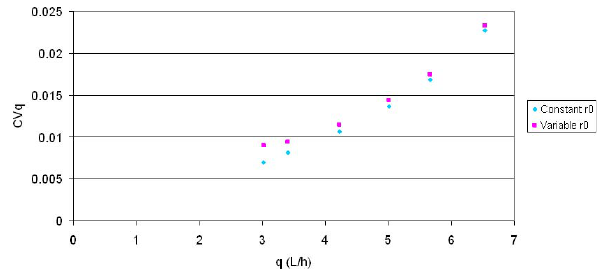
Fig. 7. Evolution of pressure in the soil around the emitter outlet as a function of emitter discharge: simulated and calculated values.